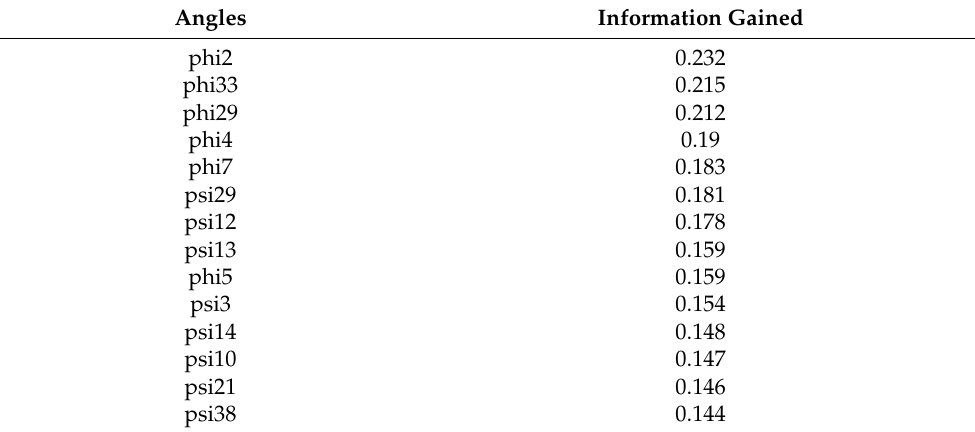
Table 4. Results of Ranking Entire Data Set by Disease.